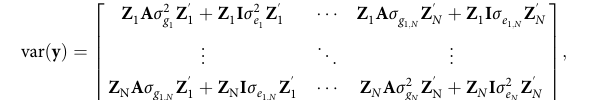
Fig. 8 Estimated SNP-based heritability of BMI decreases with increasing numbers of cohorts. The UKBB1 estimate was reported by Ge et al. 23 , which used GWAS summary statistics based on the samples from the fi rst release of UK Biobank. The GIANT2010 and GIANT 2015 estimates were reported by Duncan et al. 29 , which used GWAS summary statistics based on the GIANT consortium samples from ~80 to 125 cohorts, respectively. The UKBB1 + GIANT2015 estimate was reported by Ni et al. 30 . Bars are